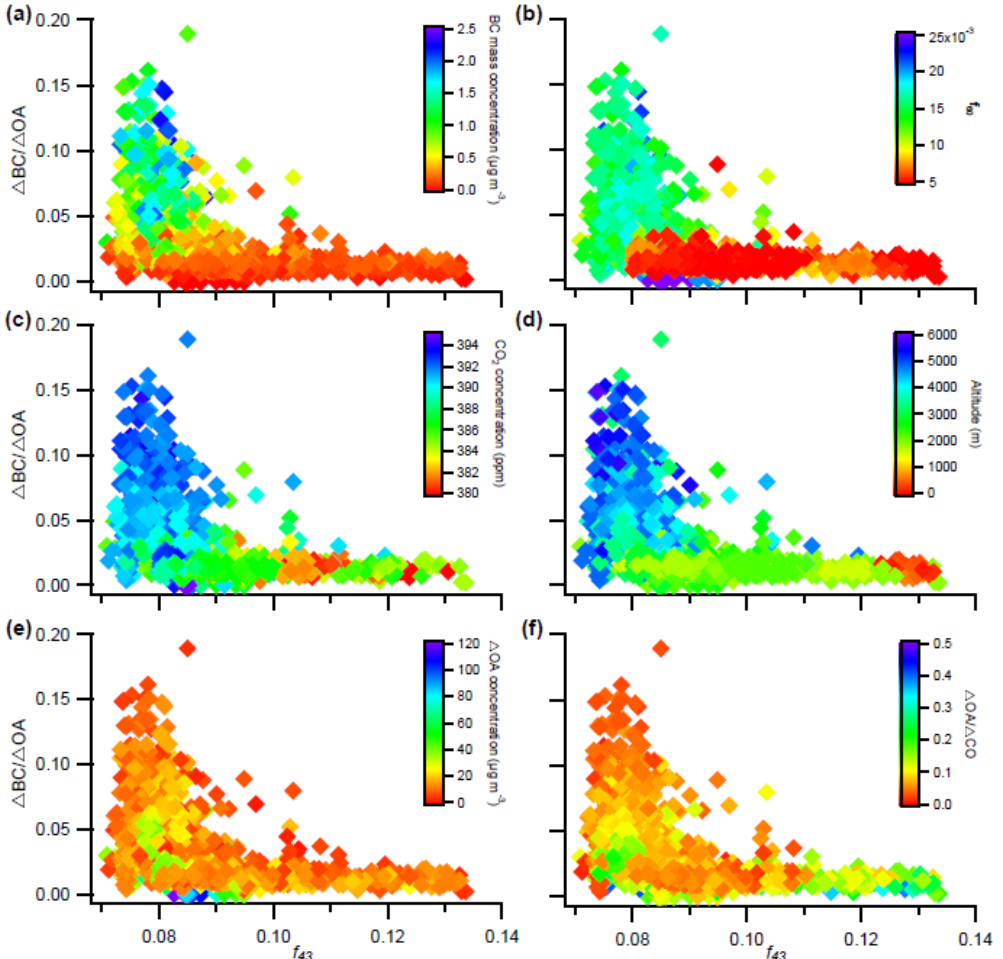
Figure 6. (cid:49) BC /(cid:49) OA vs. f 43 for aged emissions. Data points are coloured to show relationships with (a) (cid:49) BC, (b) f 60 , (c) CO 2 , (d) altitude, (e) (cid:49) OA and (f) (cid:49) OA /(cid:49) CO.